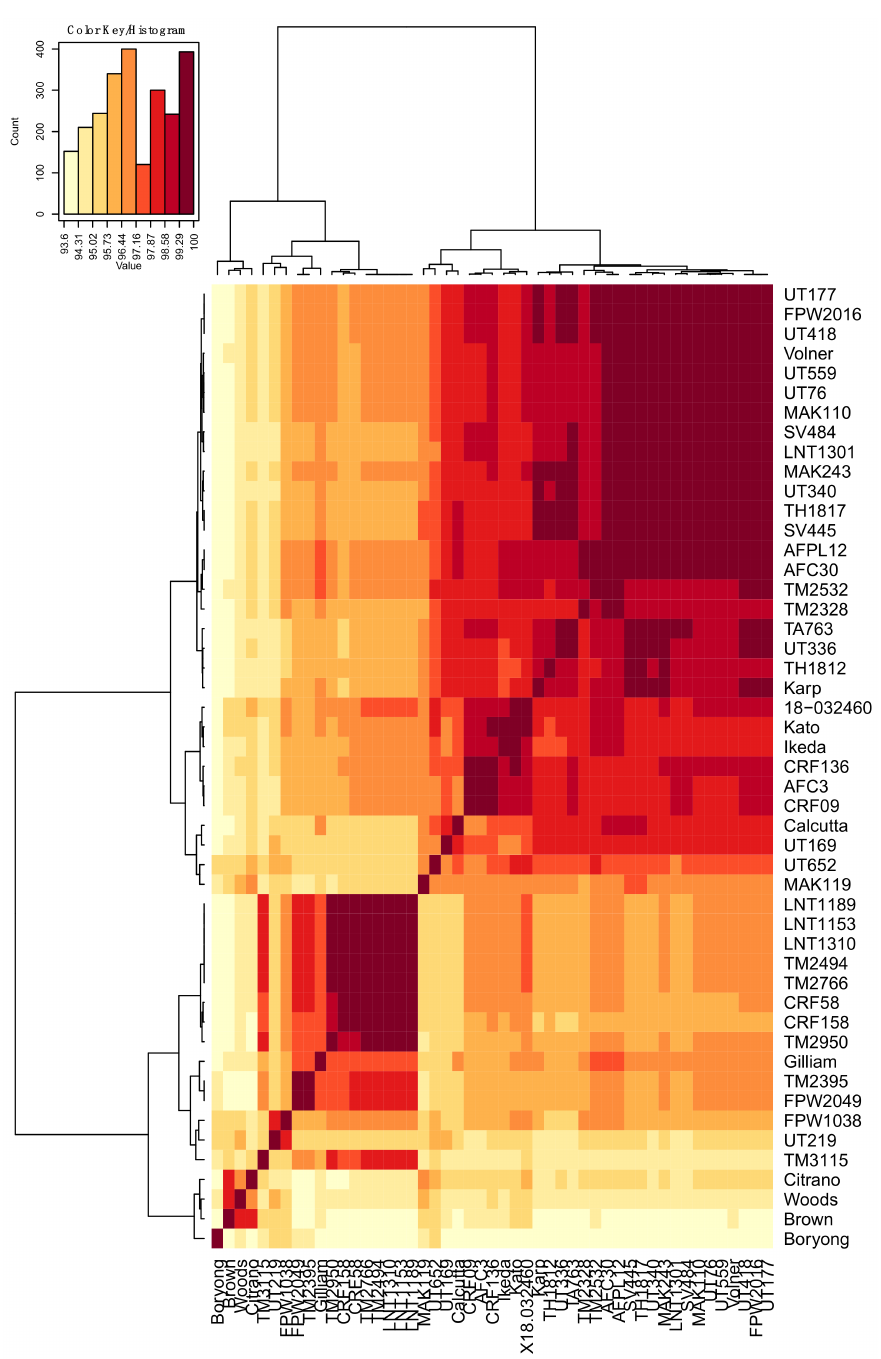
Figure 1. Heat map of percent nucleotide identity of the ompA DNA sequences among 49 O. tsutsugamushi isolates. The heat maps were generated using the pairwise identity matrix tables with hierarchical clustering method. The names of the isolates are provided on the right side and bottom of the heat map. Dendrograms are on the left side and on top of the heat